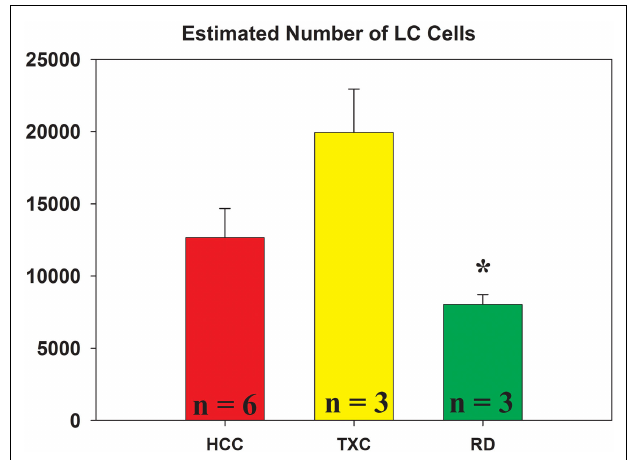
FIGURE 4 | Estimated total number ofTH-ir cells in the locus coeruleus in the three kitten groups. Values are based on fractionator stereological probe data, which provide statistically non-biased estimates of total number of cells in an area of interest. Home cage-reared (HCC)-, shaker-control (TXC)-, and RD groups are indicated on the abscissa. HCC = red bar; TXC = yellow bar; RD = green bar; ∗= different fromTXC, p = 0.024 (Bonferroni post hoc corrected t -test).